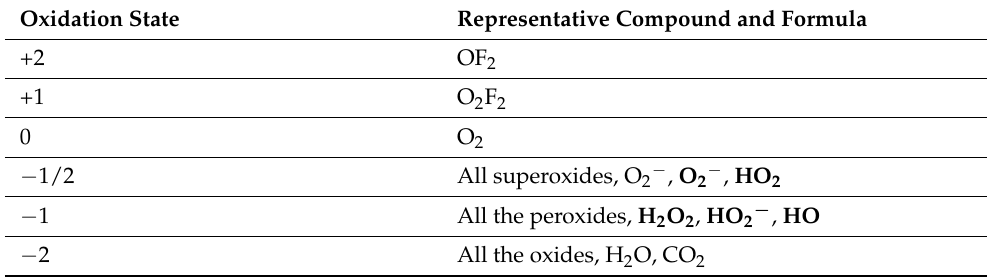
Table 1. Representative oxygen compounds and their oxidation state. ROS are in bold letters. Oxidation State Representative Compound and Formula +2 OF